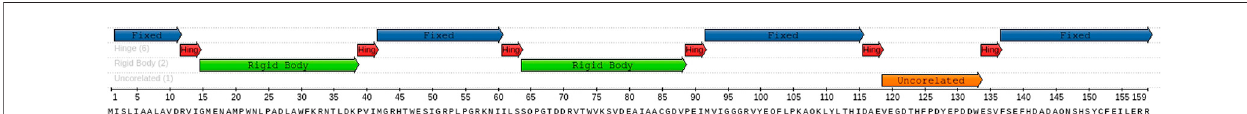
FIGURE 1 | The regions of DHFR that were subjected to MD simulation.